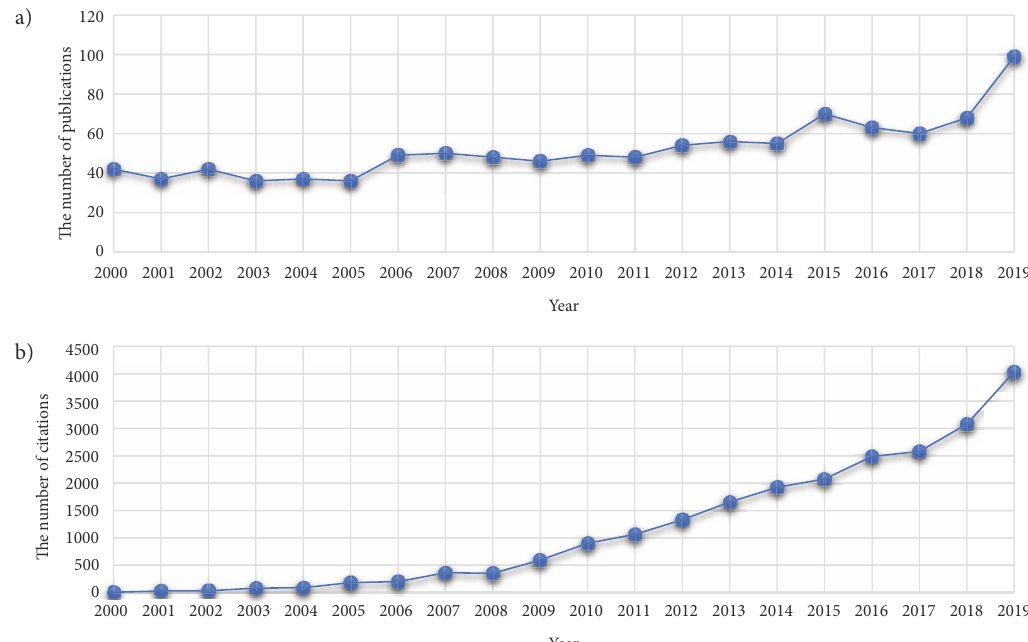
Figure 2. The NP (a) and NC (b) per year from 2000 to 2019 in the CACAIE